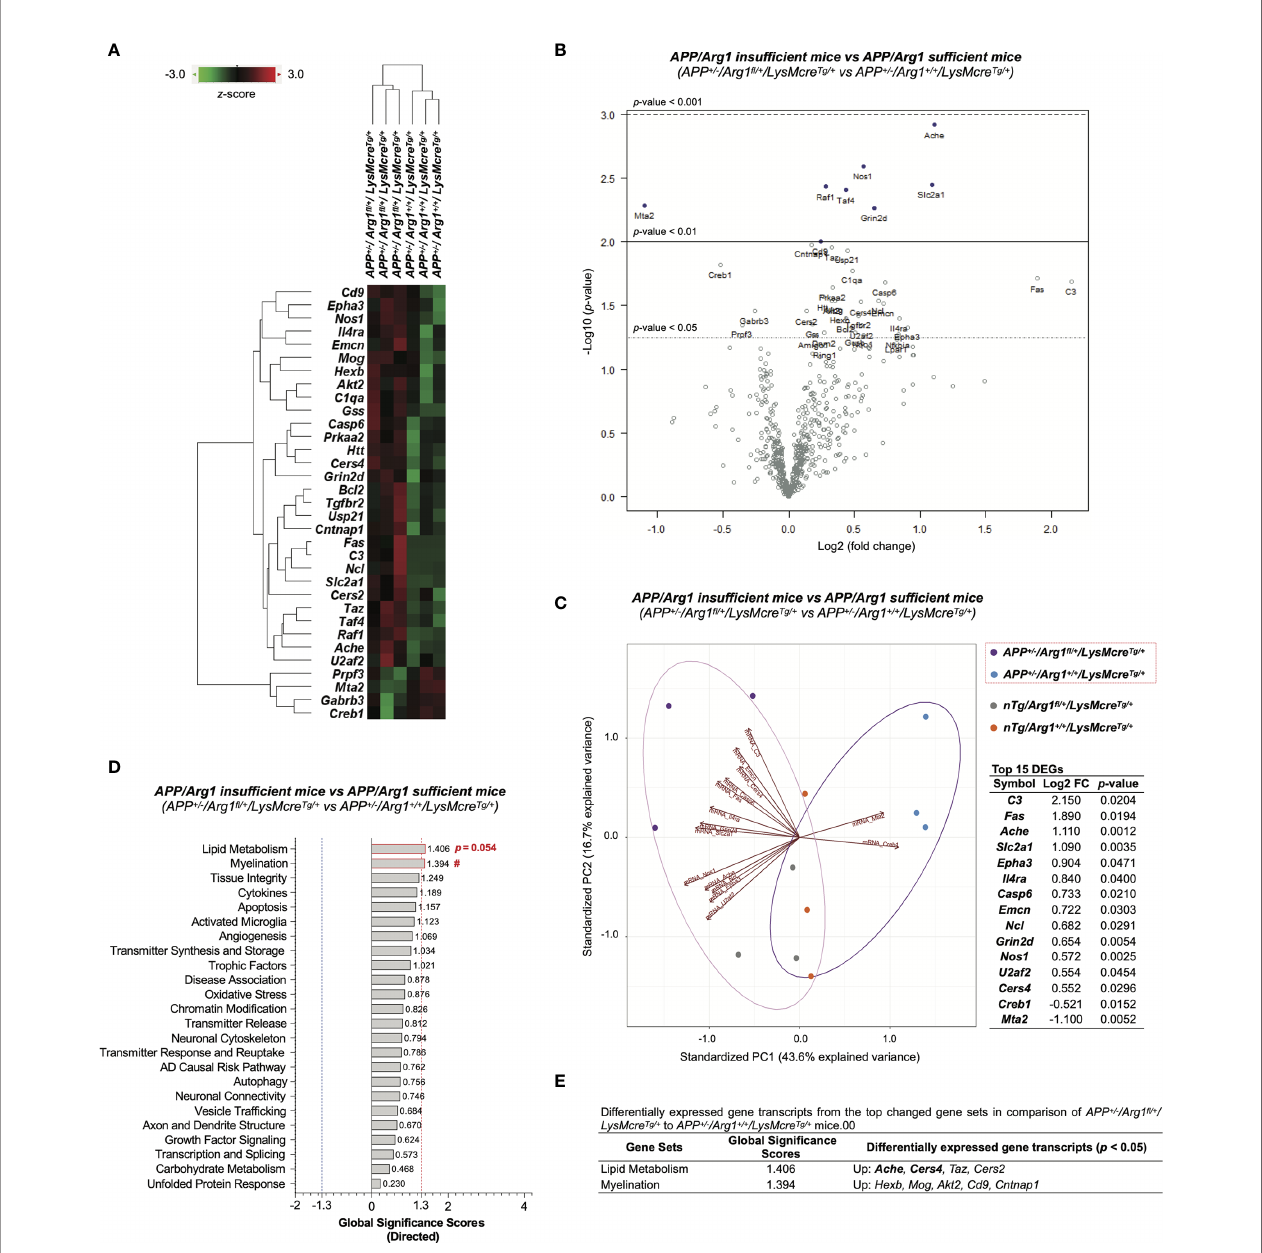
FIGURE 8 | Differential gene expression analysis of LysMcre dependent Arg1 haploinsuf fi ciency in mouse brain with amyloidosis. (A) A heat map with dendrogram trees represents agglomerative clustering of samples and differentially expressed gene transcripts (DEGs, p < 0.05) by comparing APP +/- /Arg1 fl /+ /LysMcre Tg/+ to APP +/- /Arg1 +/+ /LysMcre Tg/+ mice. The heat map uses the average Euclidean distance for the linkage and is centered and scaled by the z -score transformation. Red and green colors denote up and down expressed gene transcript, respectively. (B) A volcano plot displays all expressed genes above the background. Gene transcripts with high statistical signi fi cance stay on the top and high fold-change stay on either side. The left and right side of the volcano plot displays the down and up expressed genes, respectively. Horizontal lines indicate different thresholds of the p -values. The top 40 DEGs (based on p -values) are labeled. (C) A biplot of principal component analysis and a table are created by the top 15 DEGs with the highest fold-change variance. (D) A bar graph of gene set analysis ranks all signature pathways with directed global signi fi cance scores (GSS). The up or down regulated pathway is indicated by positive or negative GSS values. The red or blue dashed line highlights the top changed pathways based on the cut-off criterion (absolute GSS value at 1.3). The statistically changed pathways from pair-wise comparison in pathway scoring analysis are annotated with p -value or red number sign (#) for up-regulation. (E) A table lists DEGs of the top changed pathways in gene set analysis. The top 15 DEGs are bolded. Up/Down denotes up/down-regulation. n=3 samples per group representing 6 mice. The number sign (#) indicates the focused pair-wise comparison of Arg1 haploinsuf fi ciency genotype. # p < 0.05. Two-way ANOVA of 2x2 factorial analysis followed by pairwise comparisons using Fisher ’ s PLSD. See also Table S2